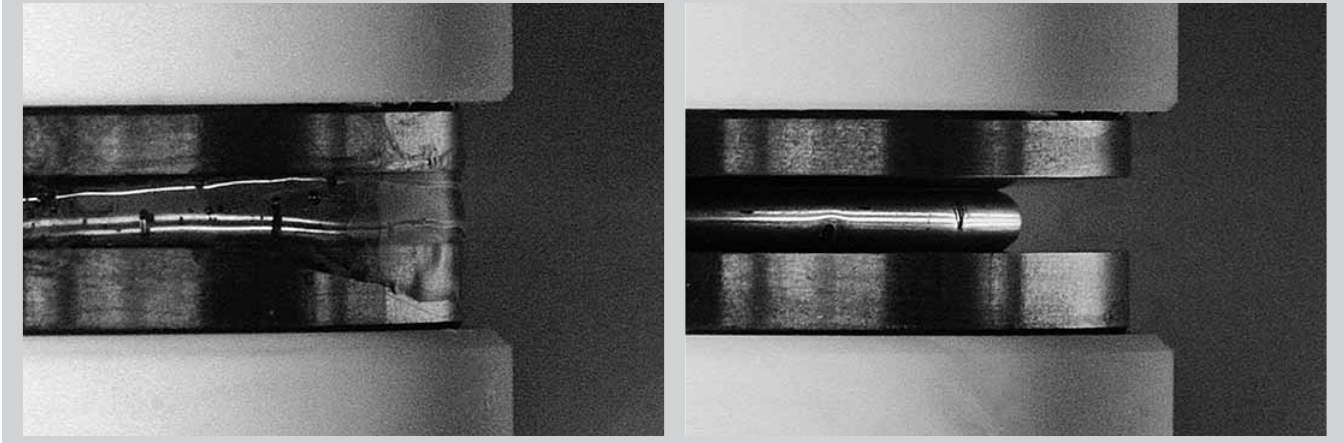
Figure 2: Images of free surface in cone and plate geometry: a) (left) free surface of poly- mer solution after excess fluid is trimmed from edge of fixtures; b) free surface of polymer melt after known mass of fluid is squeezed between